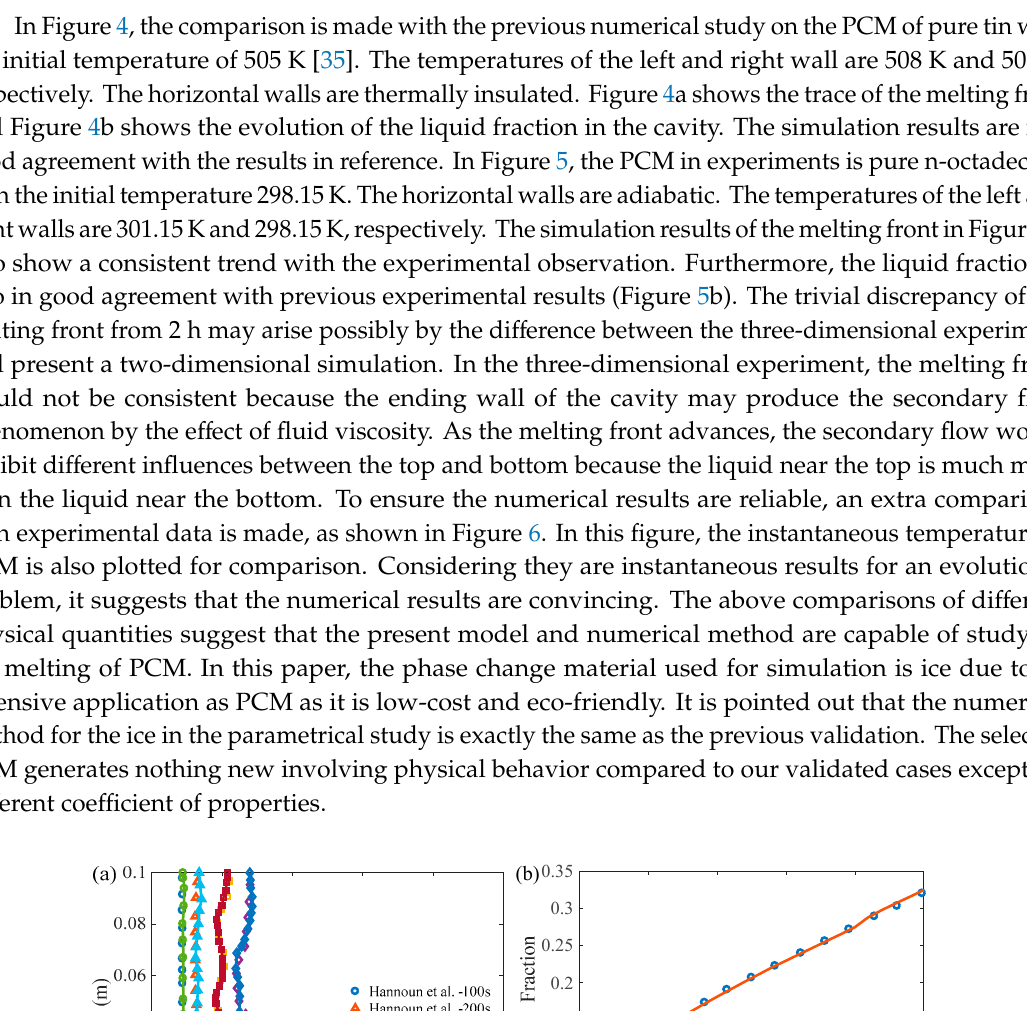
Table 1. Thermophysical properties of pure tin [35], n-octadecane [36], and ice [37].